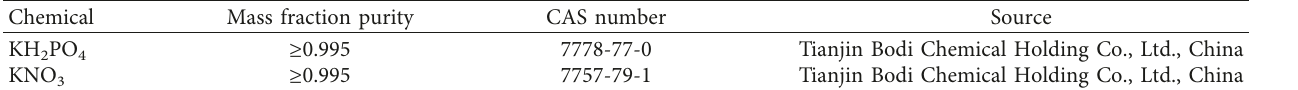
Table 2: Mass fraction solubility of the ternary KNO